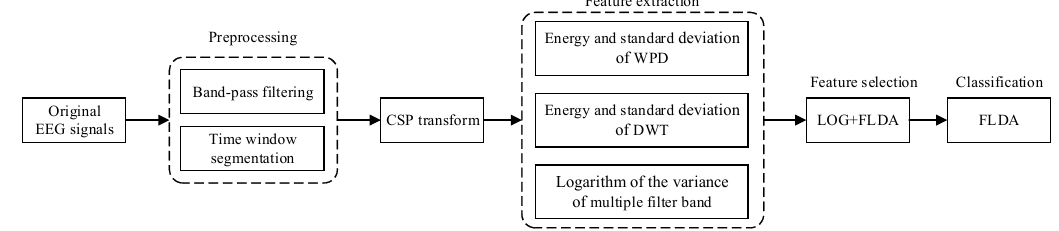
Figure 1. Distribution of electrodes on the scalp for all datasets. ( a ) dataset 1, ( b ) dataset 2, ( c ) dataset